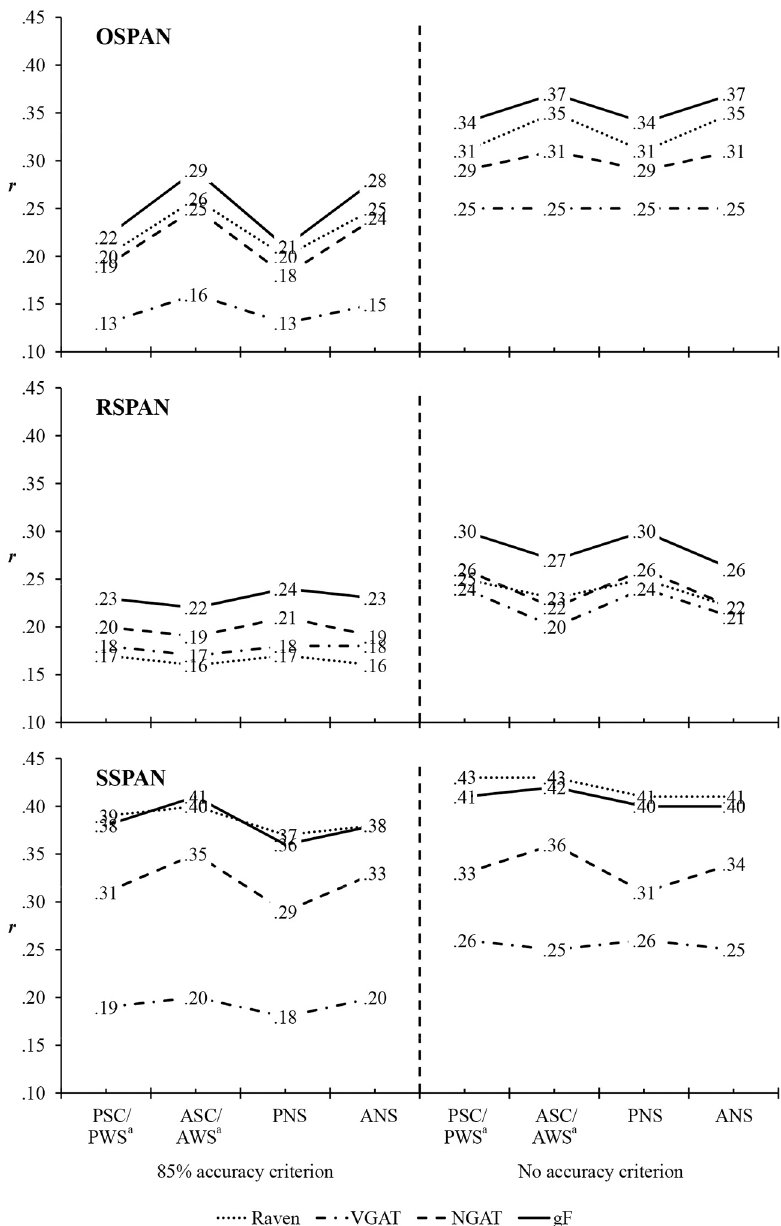
Fig 2. Correlations among working memory capacity (WMC) scores and measures of fluid intelligence ( g F) according to the accuracy criterion on the processing component of the working memory (WM) span tasks. Size of the subsample with the 85% accuracy criterion: n = 311; size of the subsample with no accuracy criterion: n = 447. All correlations are significant: correlations below .15 are significant at the p < .05 level; correlations between .15 and .18 are significant at the p < .01 level; correlations above .18 are significant at the p < .001 level. OSPAN = operation span; RSPAN = reading span; SSPAN = symmetry span; PSC = partial score; ASC = absolute score; PNS = partial non- weighted score; ANS = absolute non-weighted score; PWS = partial weighted score; AWS = absolute weighted score; Raven = Raven Advanced Progressive Matrices; VGAT = Verbal General Ability Test; NGAT = Numerical General Ability Test. a As PWS is a simple linear transformation of PSC, their intercorrelation is maximal ( r = 1), and their correlations with other measures are identical. The same holds for AWS and ASC.